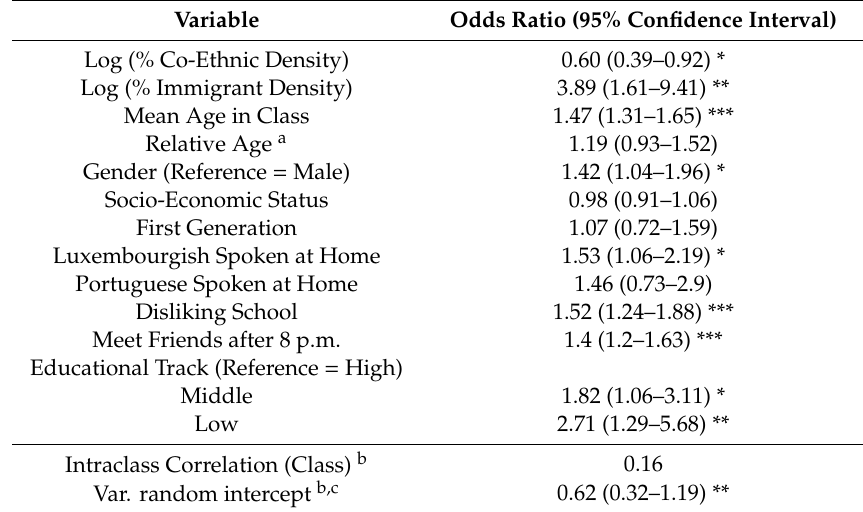
Table 1. Analyses for the subgroup of students of Portuguese descent: Direct e ff ects of co-ethnic and immigrant